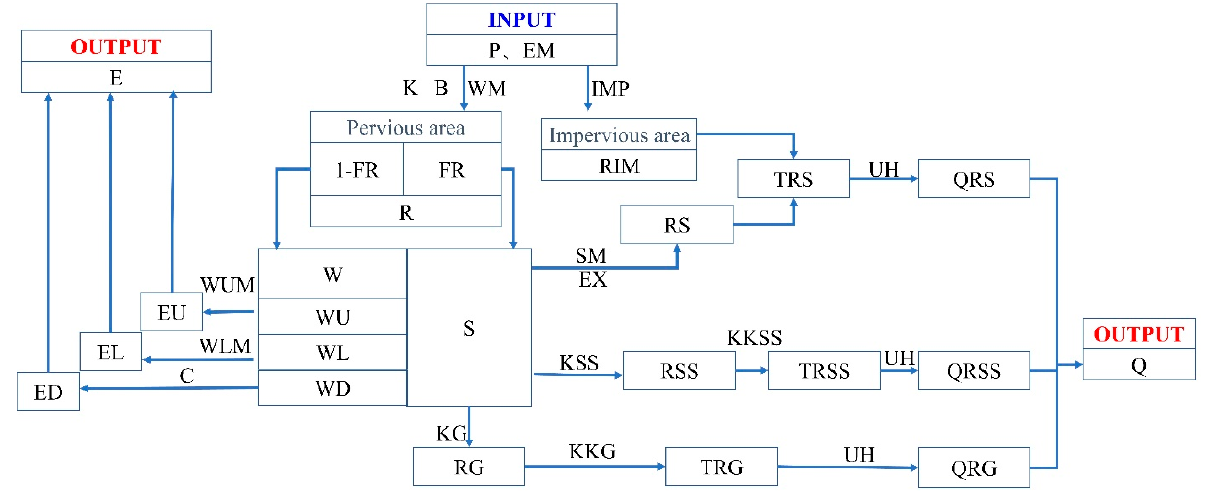
Figure 4. The framework of the XAJ model. (Variables: P, precipitation; EM, potential evapotranspi- ration; E, actual evapotranspiration, discharge at outlet; RIM, runoff from the impervious area; RS, surface runoff; RSS, interflow runoff; RG, groundwater runoff; TRS, outflows from the reservoirs of surface runoff components; TRSS, outflows from the reservoirs of interflow runoff components; TRG, outflows from the reservoirs of groundwater runoff components; QRS, surface runoff inflow to river network; QRSS, interflow to river network; QRG, groundwater inflow to river network; S, water content in free water store; FR, ratio of runoff-producing area. WUM, WLM, and WDM are the water contents in the upper, lower, and deepest layers, respectively; EU, EL, and ED are the evaporation from the upper, lower, and deepest layers, respectively; and the other parameters are introduced in Section 2.3).